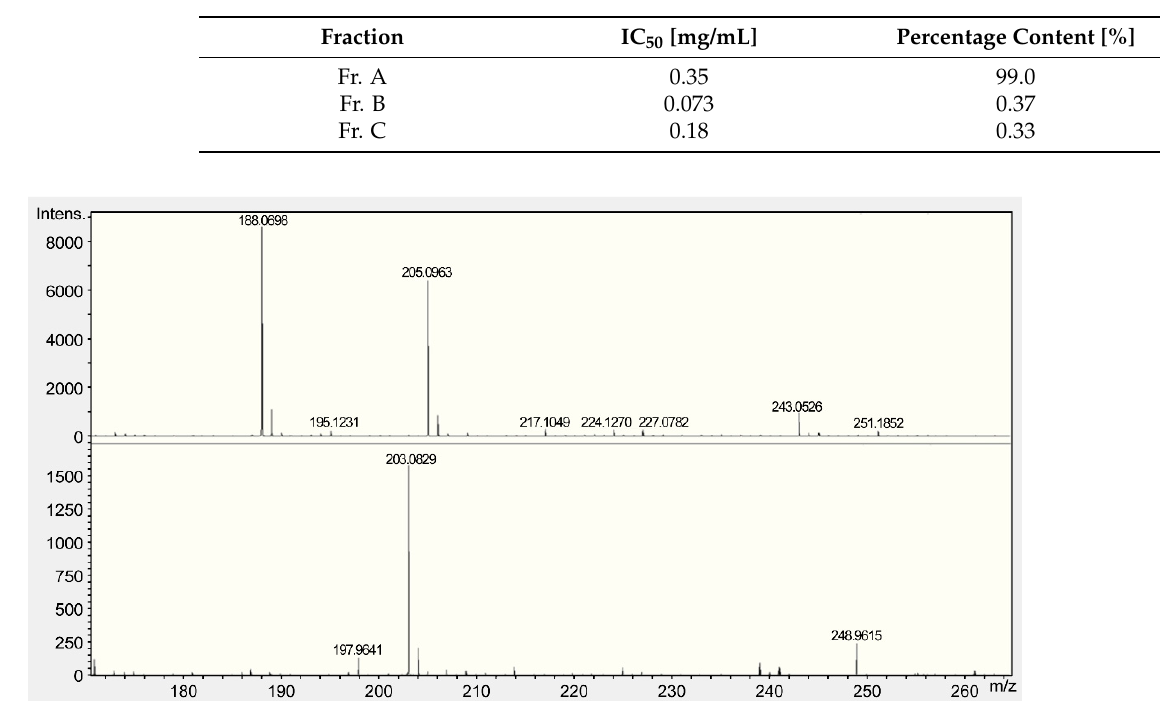
Figure 4. Mass spectroscopy spectrum of D-tryptophan (Trp).